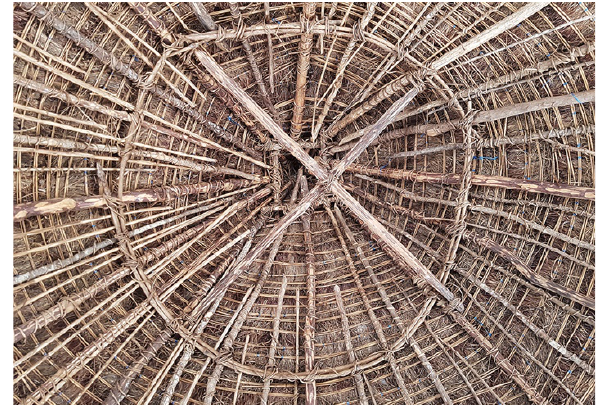
Figure 19. Roof structure of a Buglé building at El Peñón.